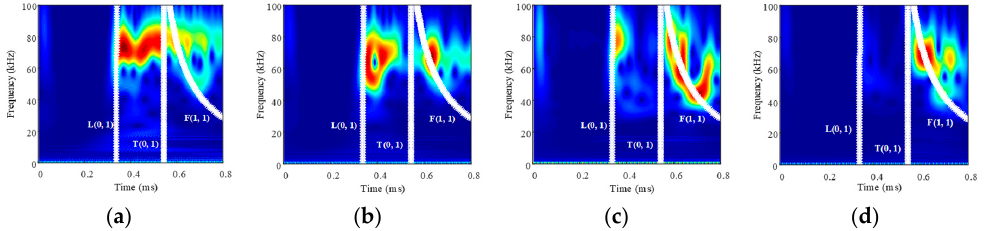
Figure 12. The time-frequency analysis spectrum using a continuous wavelet transform (CWT) for a single 7-mm-diameter steel wire at a 60-kHz frequency: ( a ) horizontal excitation and horizontal reception, ( b ) horizontal excitation but lateral reception, ( c ) lateral excitation but horizontal reception, and ( d ) lateral excitation and lateral reception. The theoretical group velocity dispersion curves obtained in Figure 1a are represented by the dotted line.